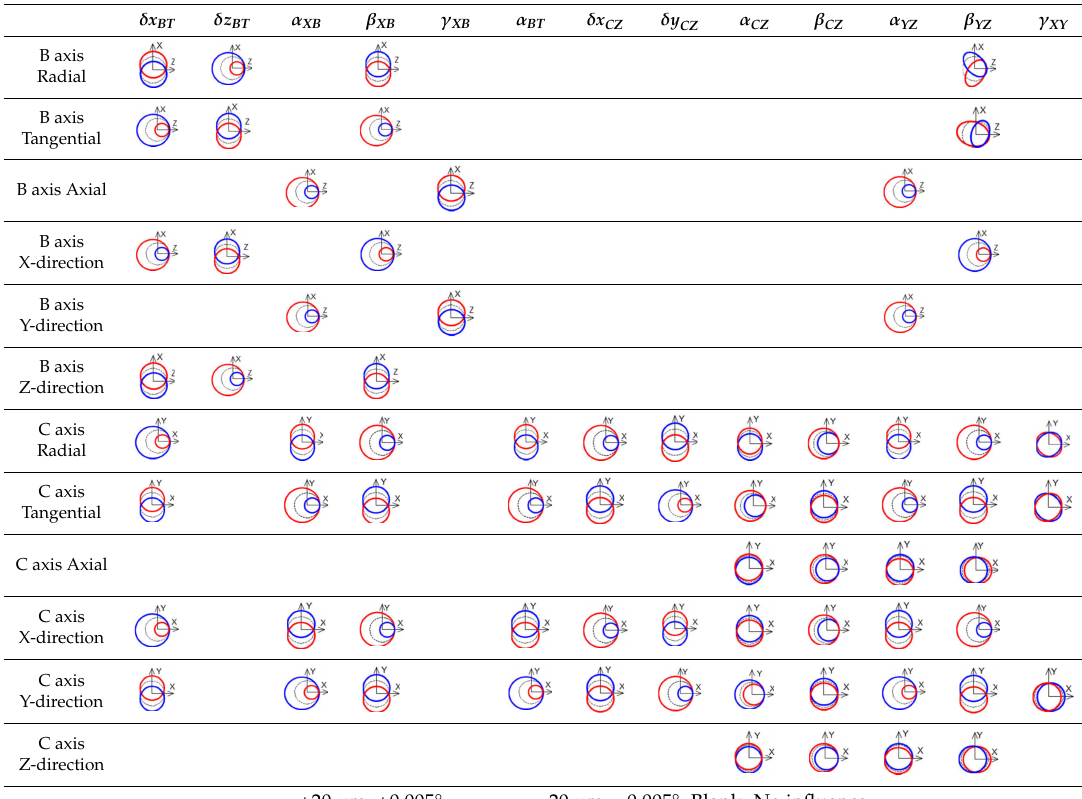
Table 3. E ff ect of geometric deviations on the eccentricities of circular trajectories in cylindrical coordinate system and in Cartesian coordinate